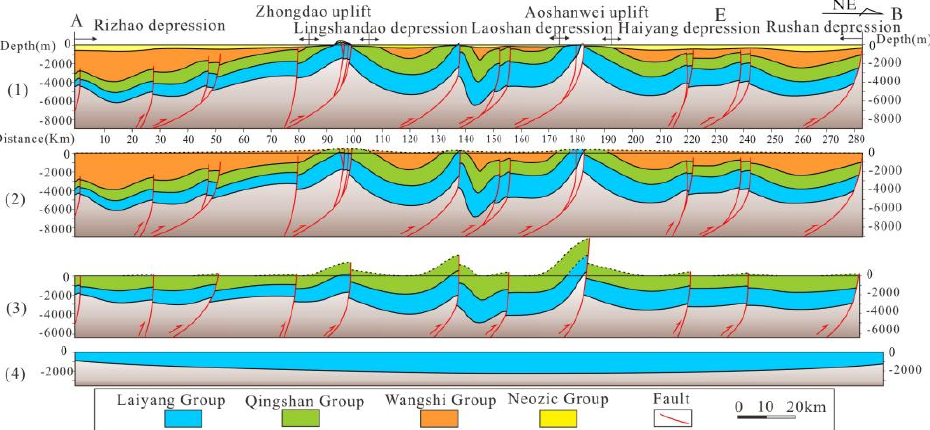
Figure 4. Profile of tectonic evolution map of southwest − northeast trending section in the Ri − Qing − Wei basin (see Figure 1 for the section location): (1) now; (2) late Wangshi period; (3) late Qingshan period; and (4) late Laiyang period.